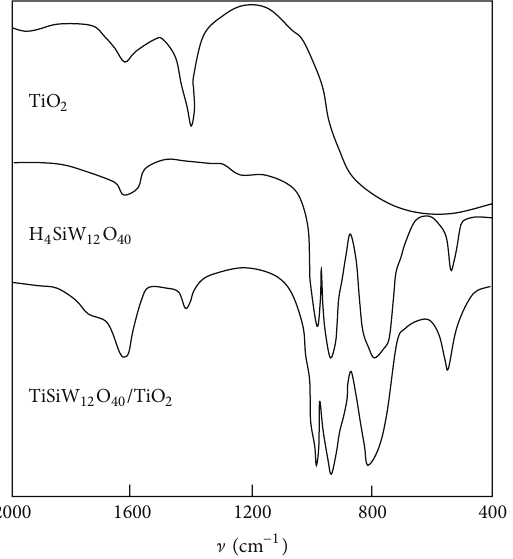
Figure 2: IR spectra of TiO 2 ⋅𝑥 H 2 O, H 4 SiW 12 O 40 ⋅𝑥 H 2 O, and TiSiW 12 O 40 /TiO 2 .